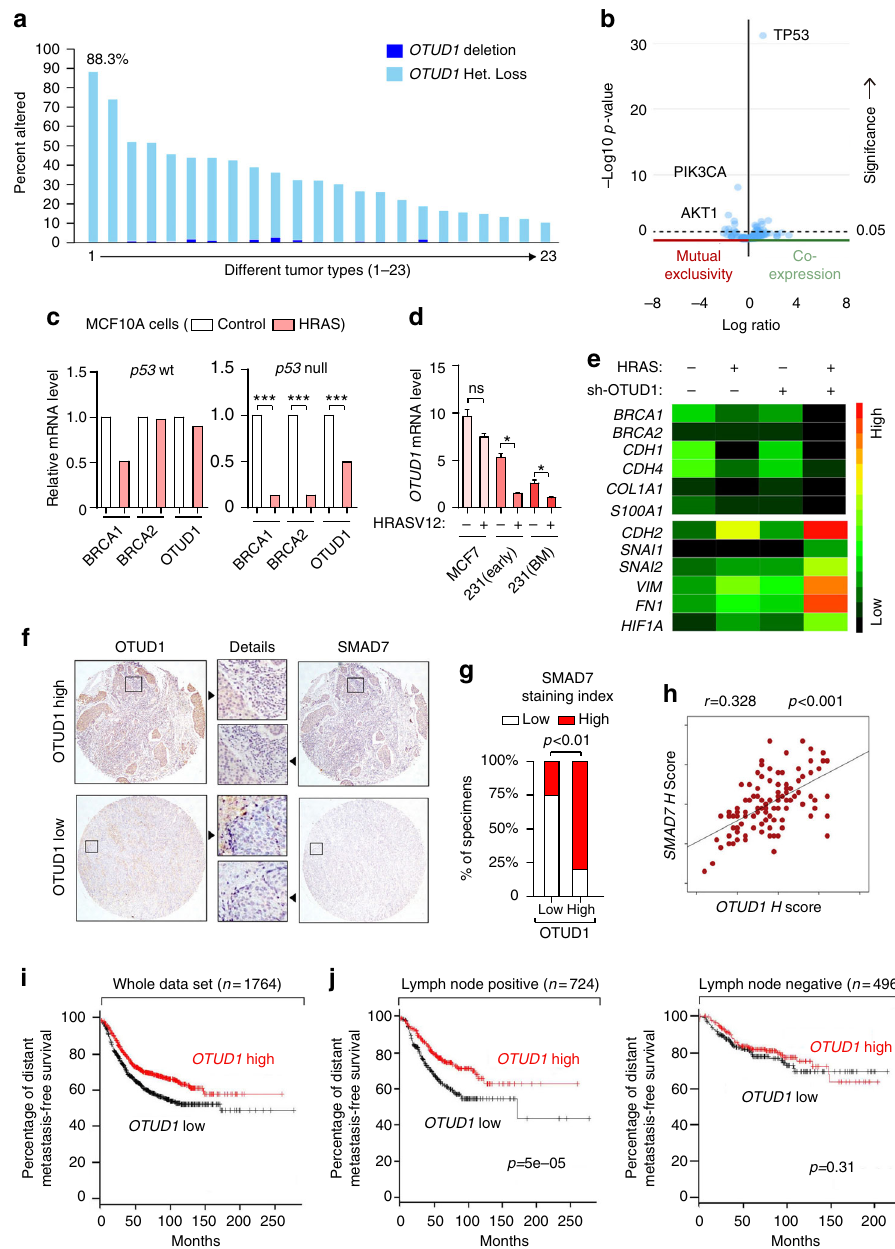
Fig. 8 OTUD1 correlates with SMAD7 in human specimens and the loss of OTUD1 gene copies in human cancer correlates with poor prognosis. a Graph showing OTUD1 gene copy loss or deletion in different tumor types. Data were obtained from the TCGA database 65, 66 . Detailed values are listed in Supplementary Table 2. b Volcano plot showing that the rare breast cancer patients with gain or ampli fi cation of OTUD1 have co-occurrence with p53 expression and mutual exclusivity with expression of PIK3CA and AKT1. Data were obtained from the TCGA database 65, 66 . c Analysis of BRCA1 , BRCA2 , and OTUD1 mRNA level in p53 wt- and p53 null- MCF10A cells expressed with or without wild-type HRAS (GSE81593 dataset). d qPCR analysis of OTUD1 mRNA level in MCF7, MDA-MB-231 (early passage), MDA-MB-231 bone-metastatic (BM) cells that ectopically express HRASV12 or control vector. Values and error bars represent the mean ± SD of triplicates and are representative of at least two independent experiments. e Heat map of mRNA level of listed genes in MCF10A cells that stably express control or HRAS with depletion of OTUD1 (sh-OTUD1), as indicated. f – h Immunohistochemistry analysis of OTUD1 and SMAD7 in breast cancer tissue microarrays; representative pictures of each antibody staining are shown ( f ). Percentage of specimens displaying low or high SMAD7 expression compared to the expression levels of OTUD1 ( g ). Scatterplot showing the positive correlation between OTUD1 and SMAD7 expression in patients; Pearson ’ s coef fi cient tests were performed to assess statistical signi fi cance h . i Kaplan – Meier curves showing that the metastasis-free survival of individuals was positively correlated with OTUD1 expression. j Kaplan – Meier curves showing that the metastasis-free survival of individuals was positively correlated with OTUD1 expression in lymph node positive patient (Left) and has no correlation with OTUD1 in lymph node negative patients (Right). * p < 0.05 and *** p < 0.001 (two-tailed Student ′ s t -test ( d , g ), Pearson ’ s coef fi cient tests ( h ) or Log-rank test ( i , j